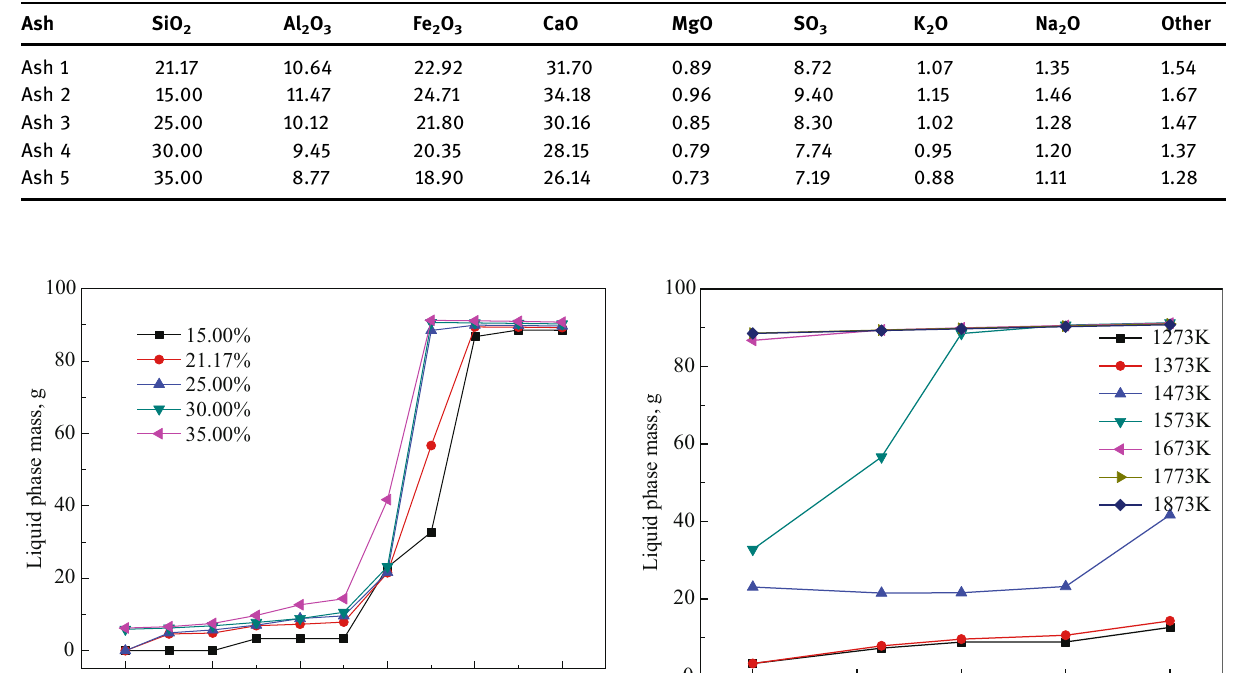
Table 6: Ash composition of di ff erent SiO 2 content ( wt% )